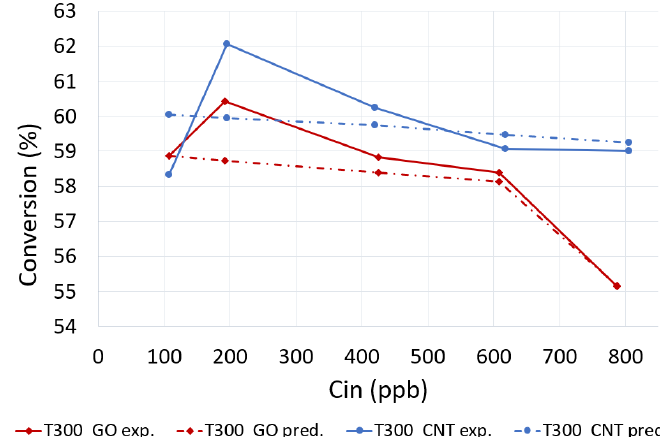
Figure 6. Experimental and predicted with the modified Langmuir–Hinshelwood (L-H) model parameters NO x conversion yield.